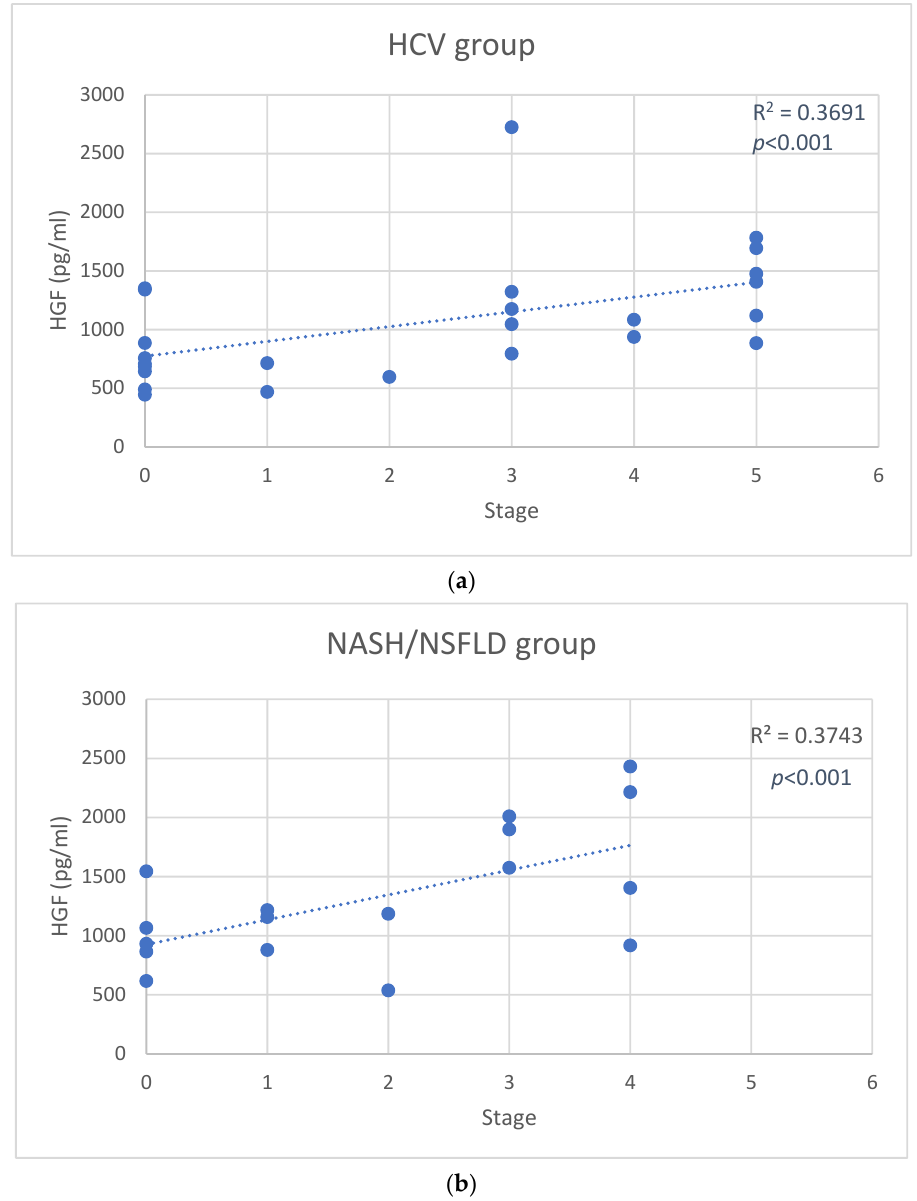
Figure 1. Scatter plot of hepatocyte growth factor (HGF) changes versus stage in the hepatitis C virus (HCV) group ( a ), and in the nonalcoholic steatohepatitis (NASH)/nonalcoholic fatty liver disease (NAFLD) group ( b ). Solid lines represent the linear fit of